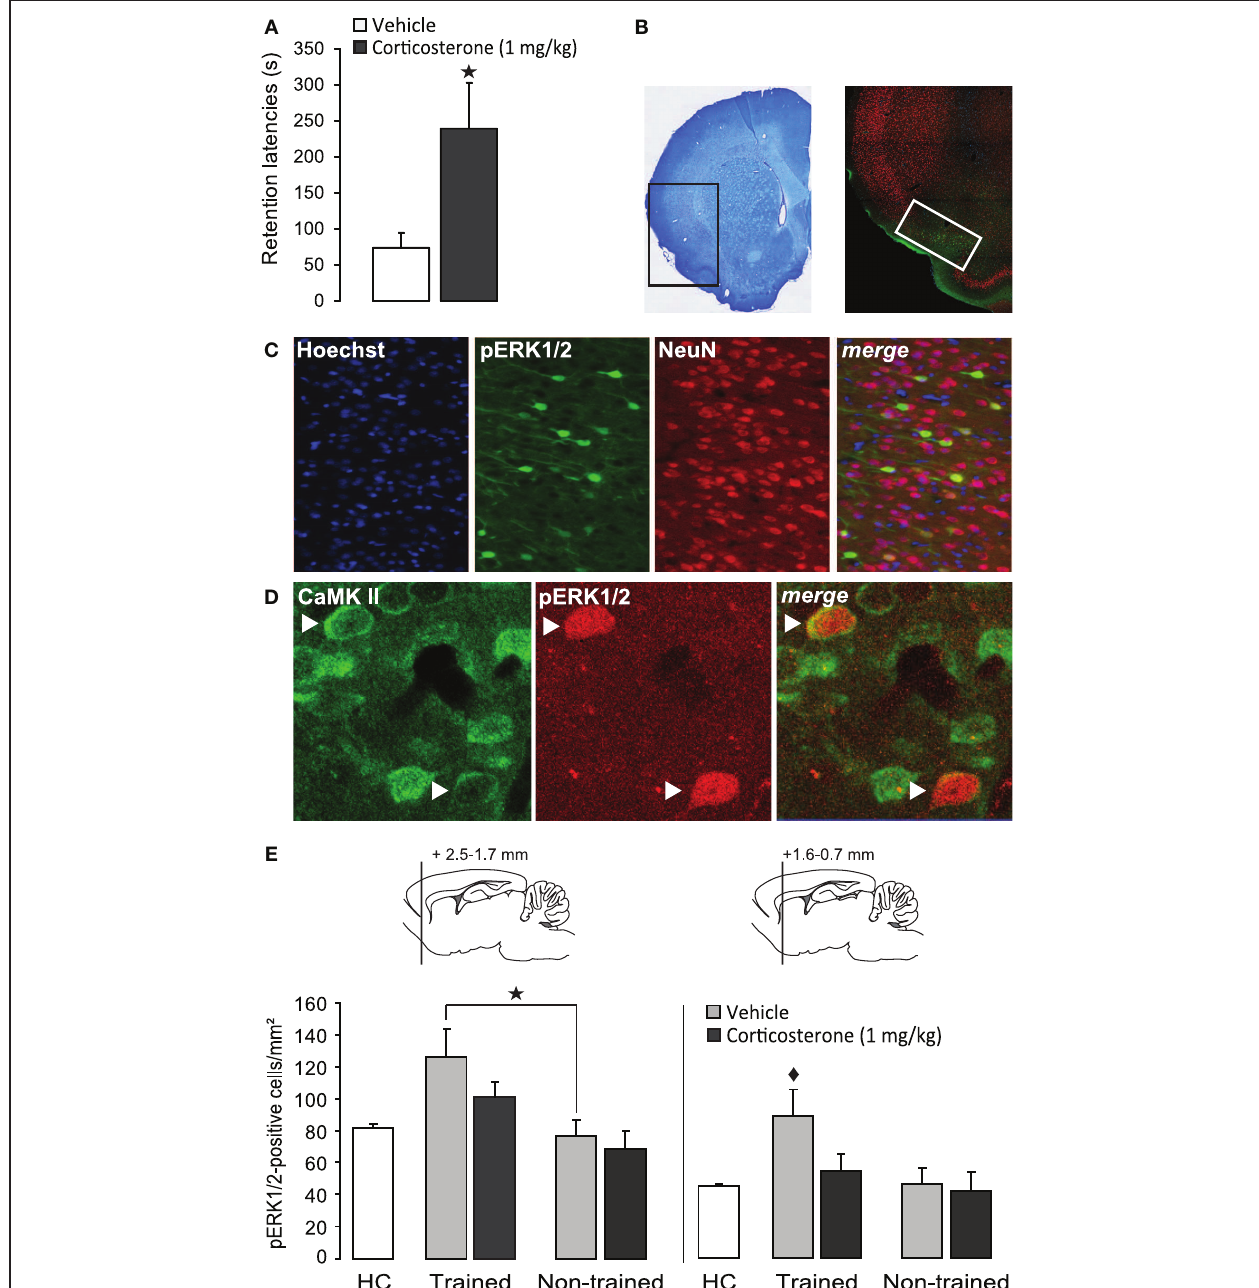
FIGURE 2 | Systemic injection of a memory-enhancing dose of corticosterone after one-trial inhibitory avoidance training reduces pERK1/2-immunoreactivity in the insular cortex. (A) Step-through latencies (mean ± SEM) in seconds on a 48h inhibitory avoidance retention test of rats given a subcutaneous injection of corticosterone (1mg/kg) or vehicle immediately after training. ∗ p < 0 . 05 ( n = 8–9 per group). (B) Example of a Nissl-stained coronal section depicting the region that was acquired for the analyses of immunostaining and the distribution pattern of pERK1/2 expression in the insular cortex. The white square indicates the region analyzed for cell counts. (C) Triple localization of Hoechst (blue), pERK1/2 (green) and the neuronal marker NeuN (red) in the insular cortex. Merging the three channels demonstrates that all pERK1/2-positive cells